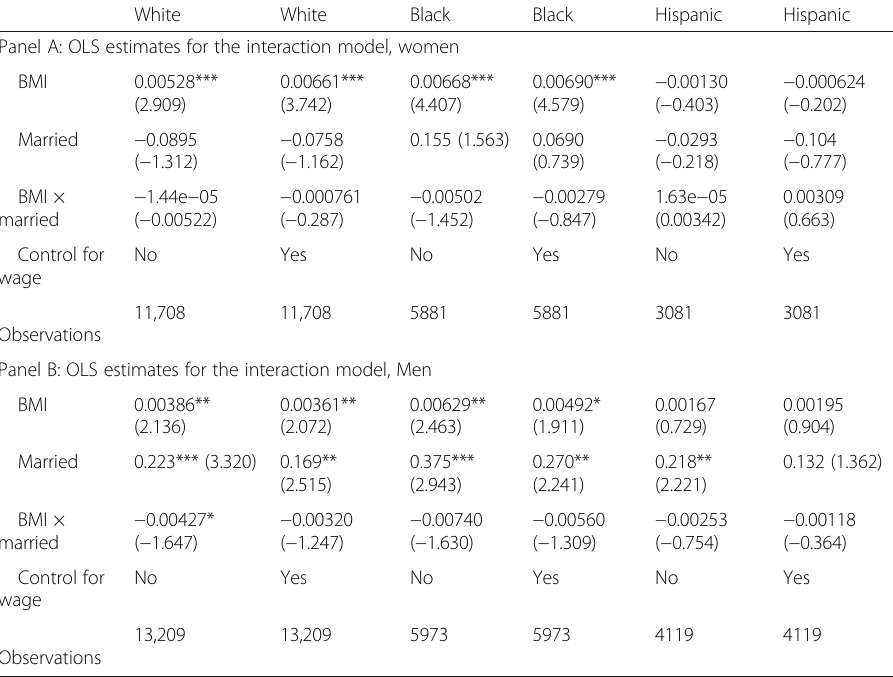
Table 4 BMI and hours work in men and women: does marital status matter? White White Black Black Hispanic Hispanic Panel A: OLS estimates for the interaction model, women BMI